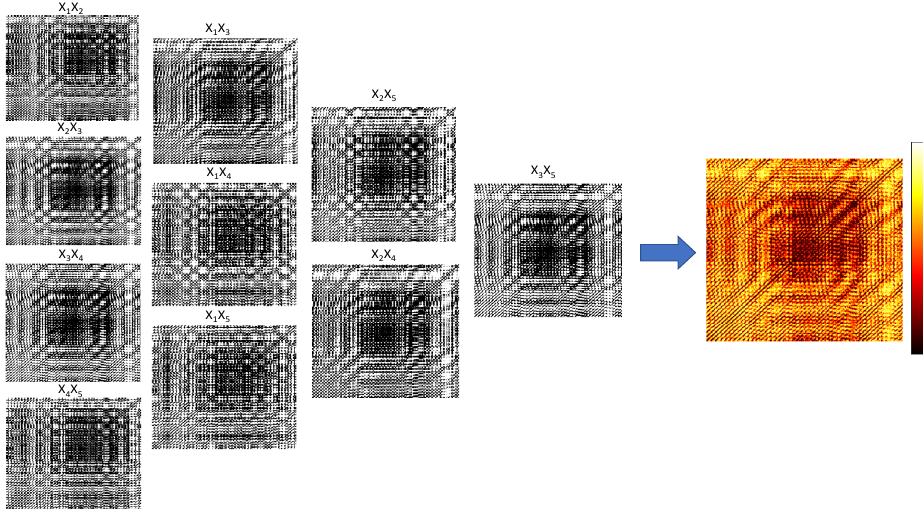
Figure 5. A schematic diagram illustrating the formation of the Color recurrence plot for a normal bearing test data without a fault. The embedding dimension d = 5 yields ten different dichotomous recurrence plots based on a fixed time lag. The first column represents recurrence plots with a single time delay ( τ 1 , τ 2 , τ 3 , and τ 4 ). The second column represents recurrence plots with double time delays ( τ 1 + τ 2 , τ 2 + τ 3 , and τ 3 + τ 4 ). The third column represents triple time delays ( τ 1 + τ 2 + τ 3 , and τ 2 + τ 3 + τ 4 ). The fourth column represents a recurrence plot with the maximal time delay ( τ 1 + τ 2 + τ 3 + τ 4 ). The Color recurrence plot is produced by the arithmetic averaging of dichotomous plots; the number of different colors is 11. The Color recurrence plot is enlarged for